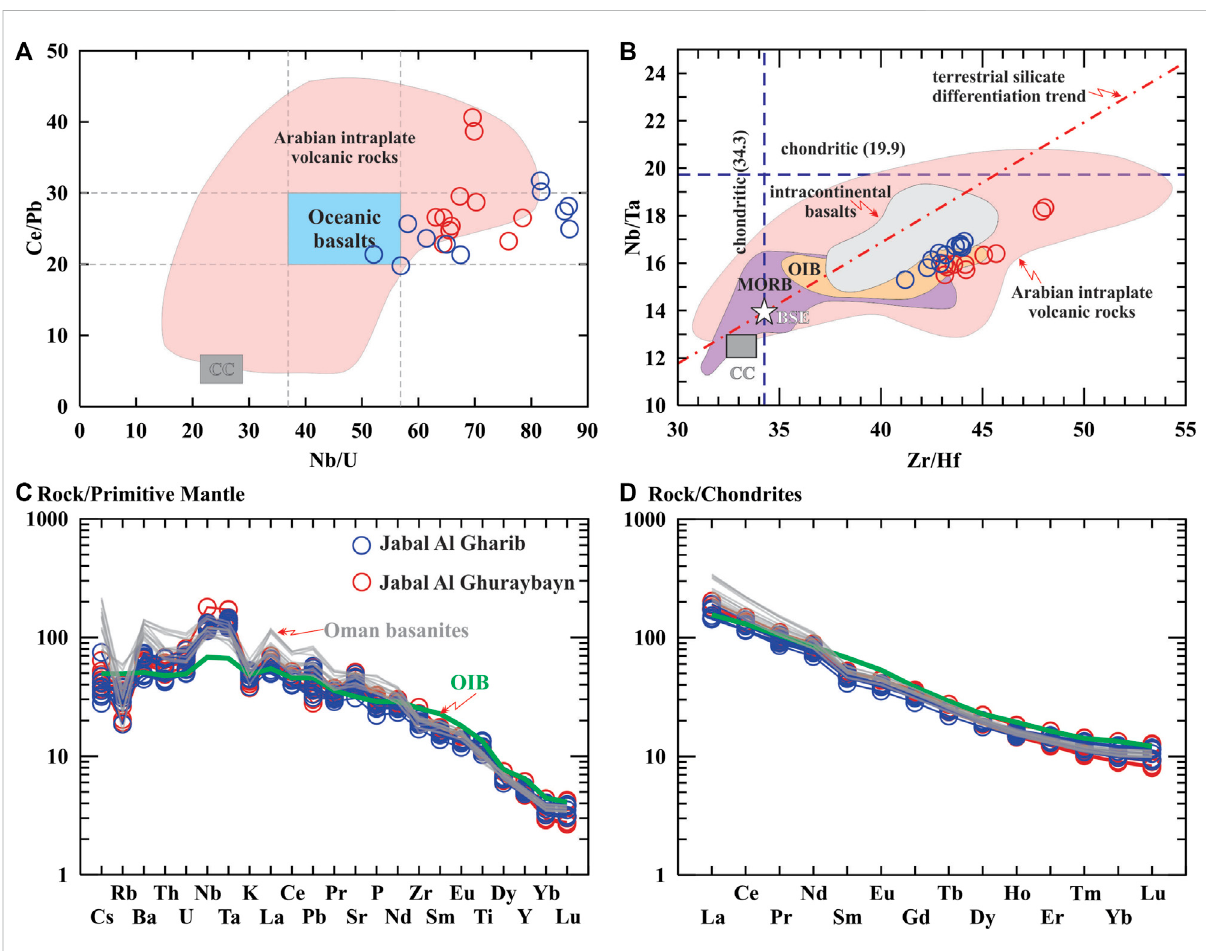
FIGURE 6 (A) Ce/Pb vs. Nb/U diagram. The ice blue fi eld denotes the range of oceanic basalts (Hofmann et al., 1986), whereas the “ CC ” gray fi eld represents the range of continental crust (Kemp and Hawkesworth, 2004; Rudnick and Gao, 2004). (B) Zr/Hf vs. Nb/Ta diagram. The chondritic values, terrestrial silicate differentiation trend, and intracontinental basalts fi eld are from Pfänder et al. (2012). Data sources: Arabian intraplate volcanic rocks (Stein and Hofmann, 1992; Krienitz et al., 2006, 2007, 2009; Witte et al., 2017); OIB (Pfänder et al., 2007); MORB (Büchl et al., 2002);continentalcrust(CC:Barthetal.,2000);bulksilicateEarth(BSE:Münkeretal.,2003). (C) Primitivemantle-normalizedtraceelementpatterns. (D) Chondrite-normalized REE patterns. Normalization values and average OIB are from Sun and McDonough (1989). Tertiary rift-related intraplate basanites from the Batain basin in northeastern Oman are used for comparison (Witte et al.,